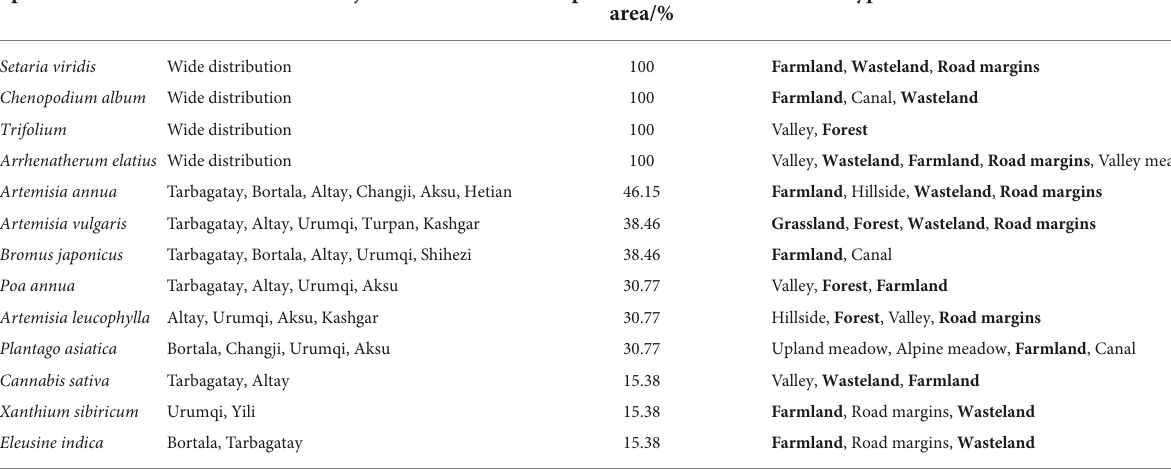
TABLE 4 Distribution of indicator species in potential suitable areas of Ambrosia artemisiifolia in Xinjiang.